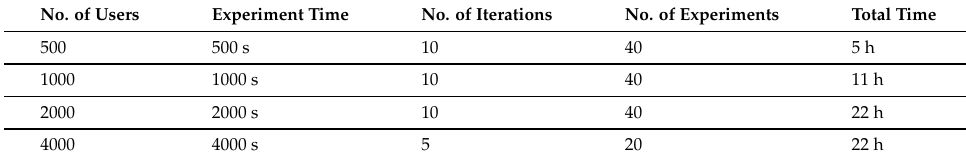
Table 4. Experimental parameter